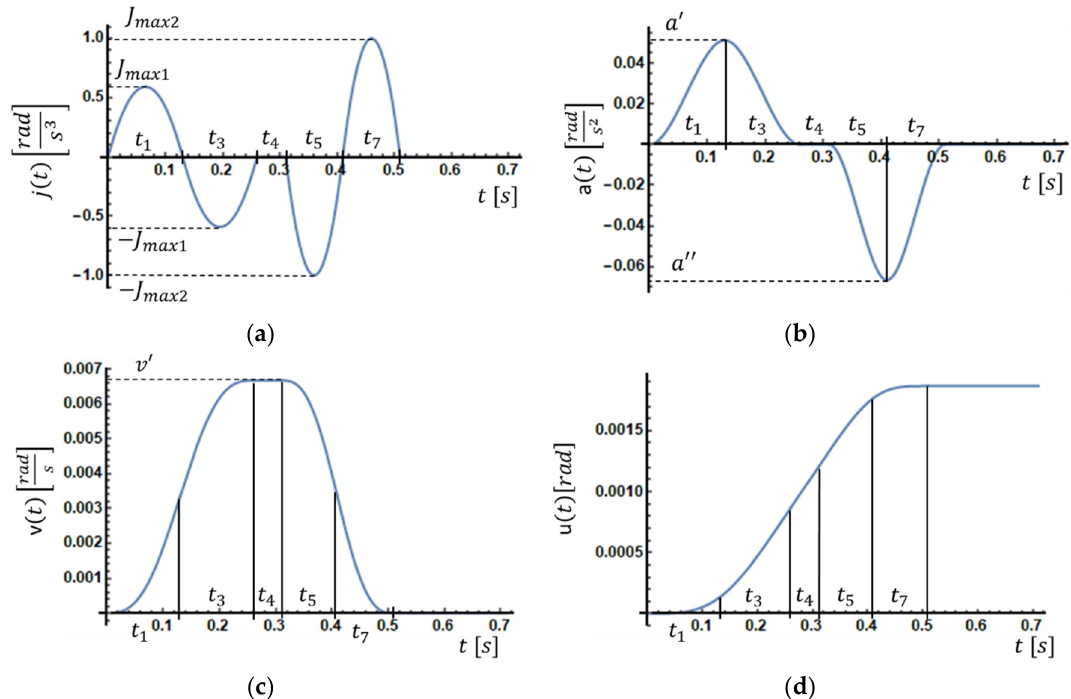
Figure 1. Jerk ( a ), acceleration ( b ), velocity ( c ) and displacement ( d ) profiles for a short move.